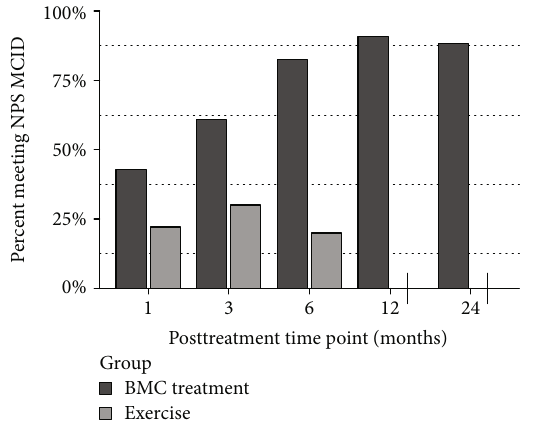
Figure 5: Percentage of patients who met MCID for NPS. Exercise N : 9, 10, 5; treatment N : 21, 23, 23, 22,